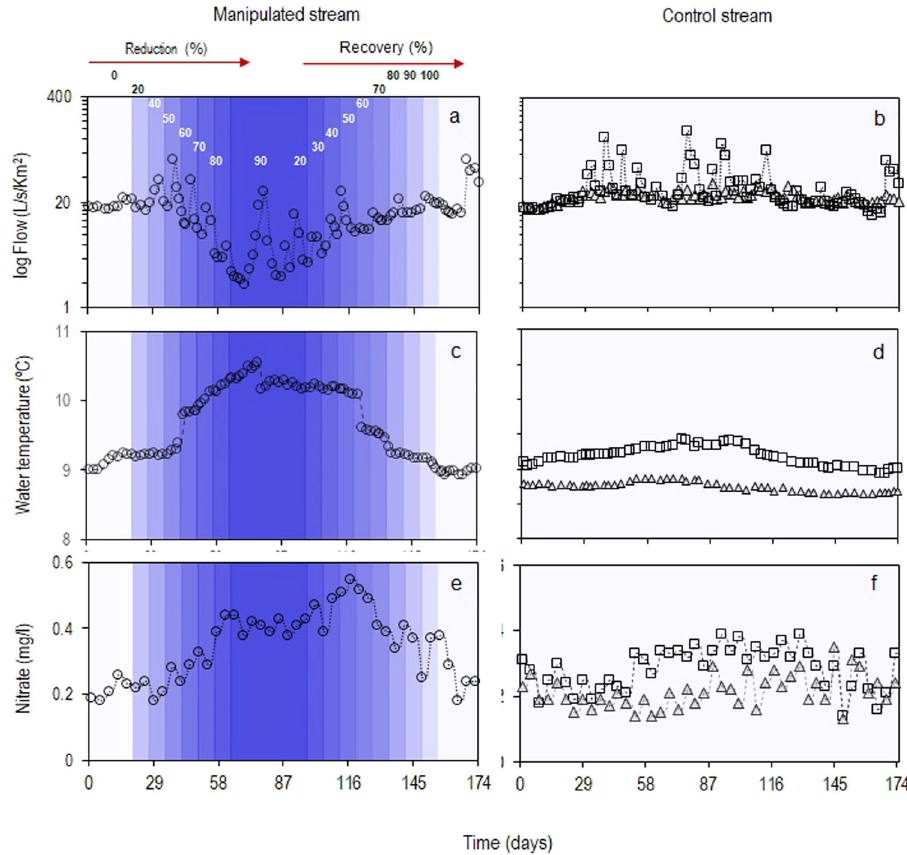
Fig. 2 Environmental variables during experimental fl ow manipulations and natural fl ow. a , c , e Time-series (open symbols) and smoothed-state estimates (dotted lines) for the manipulated stream (circles) during gradual fl ow reductions and recoveries of the 20, 40, 50, 60, 70, 80, 90%, and 20, 30, 40, 50, 60, 70, 80, 90, and 100% of upstream fl ow (blue shades), while maintaining daily fl uctuation ( b , d , f ) natural fl ow conditions for the upstream reach of the experimental site (squares) and the upstream reach of the control site